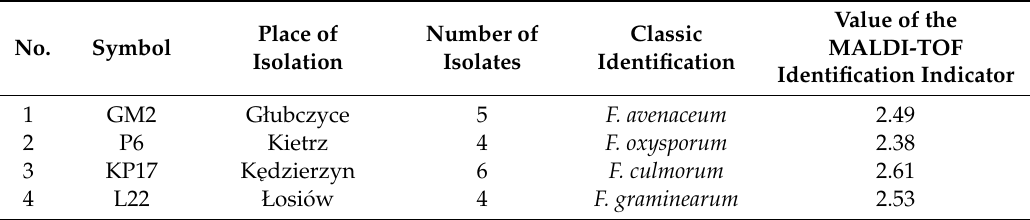
Figure 1. Morphological features of the tested species of the Genus Fusarium on PDA medium (Potato Dextrose Agar): ( a ) F. avenaceum ; ( b ) F. culmorum ; ( c ) F. graminearum ; ( d ) F. oxysporum . Table 1. Identification results of Fusarium species isolated from wheat kernels from the south of Poland. MALDI-TOF: matrix-assisted laser desorption/ionization time of flight mass spectrometer.